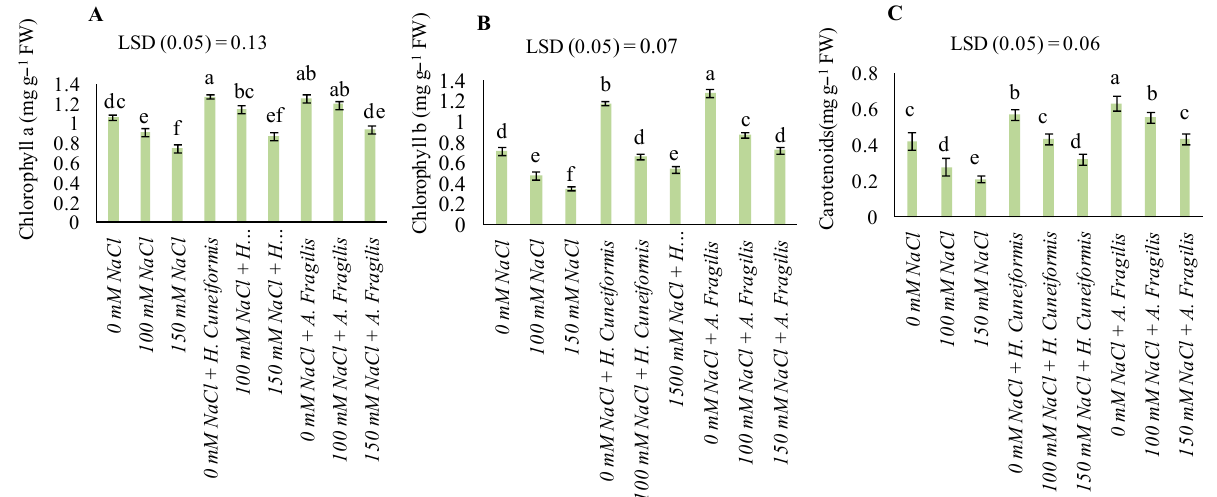
Figure 4. The effect of salinity stress on chlorophyll a ( A ), chlorophyll b ( B ) and carotenoids ( C ) in wheat ( Triticum aestivum L.) primed with H. cuneiformis and A. fragilis extracts. Treatments include 0 mM NaCl, 100 mM NaCl, 150 mM NaCl, 0 mM NaCl + H. cuneiformis , 100 mM NaCl + H. cuneiformis , 150 mM NaCl + H. cuneiformis , 0 mM NaCl + A. fragilis , 100 mM NaCl + A. fragilis , 0 mM NaCl + A. fragilis . Different letters for each mean show statistically significant differences according to the least significant difference (LSD) test ( p < 0.05).